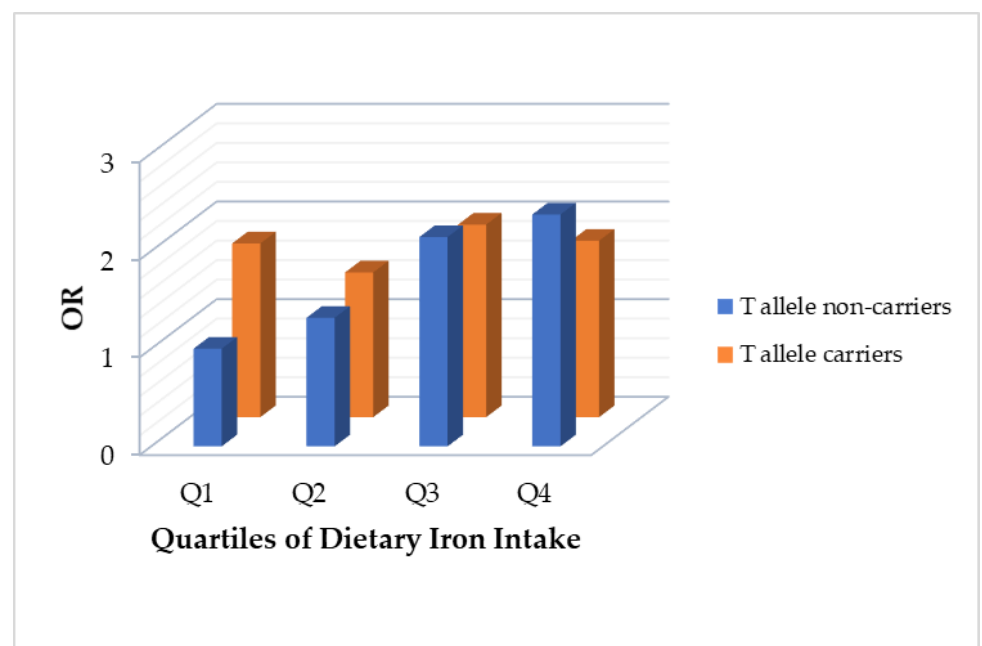
Figure 2. The association between dietary iron intake and MetS risk stratified by the T allele presence of rs516946 among the male participants.